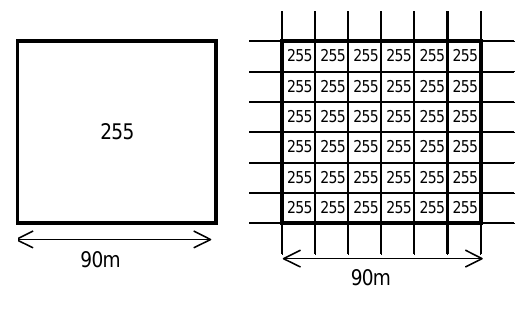
Figure 3. Re-sampling example for TIR